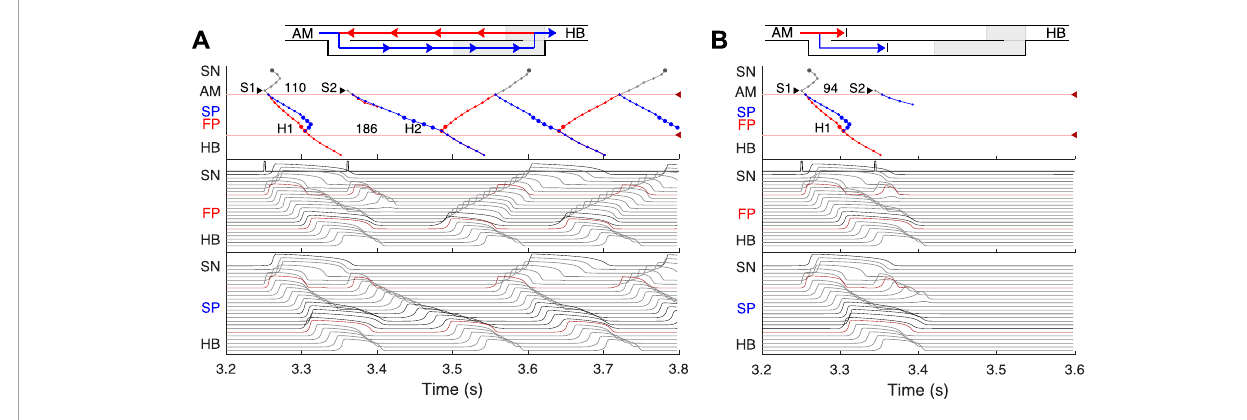
FIGURE 7 SP and FP ablations. (A) Atrial pacing with S1S2 interval of 110 ms after SP ablation. See Figure 6A for comparison. (B) Atrial pacing with S1S2 interval of 140 ms after FP ablation. See Figure 5A for comparison.